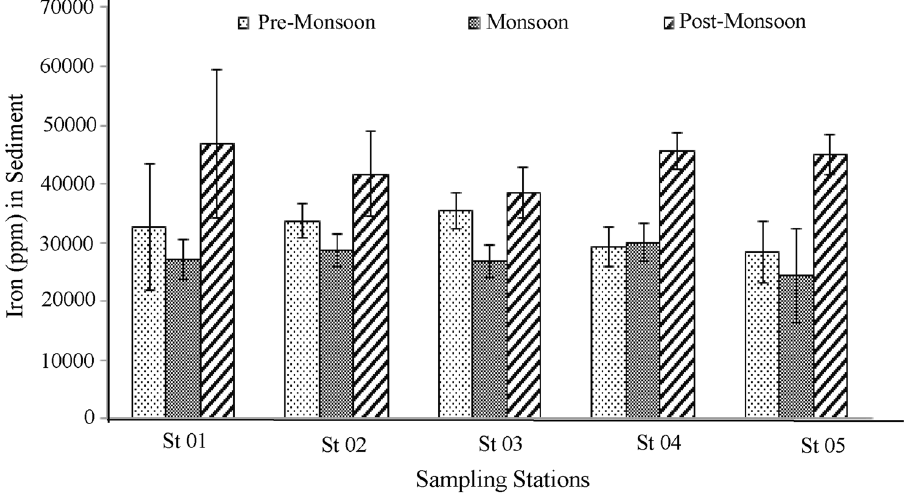
Fig. 2 Sediment iron concentra- tion (± SD) variation at different seasons in different stations of